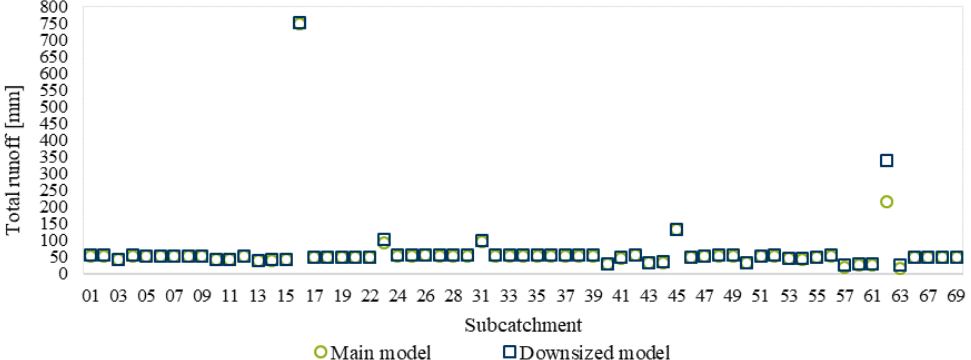
Figure 14. The total runoff amount predicted by the original model compared to the total runoff amount predicted by the downsized model.